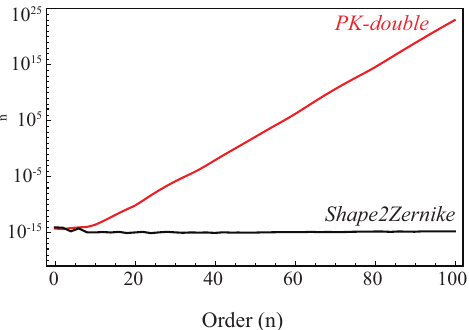
Figure 7. Accuracy of the computation of Zernike moments for a cube with 12 facets as a function of the order n . The reference values were computed symbolically using a symbolic algebra system. The approximate algorithm is indistinguishable from the exact one.